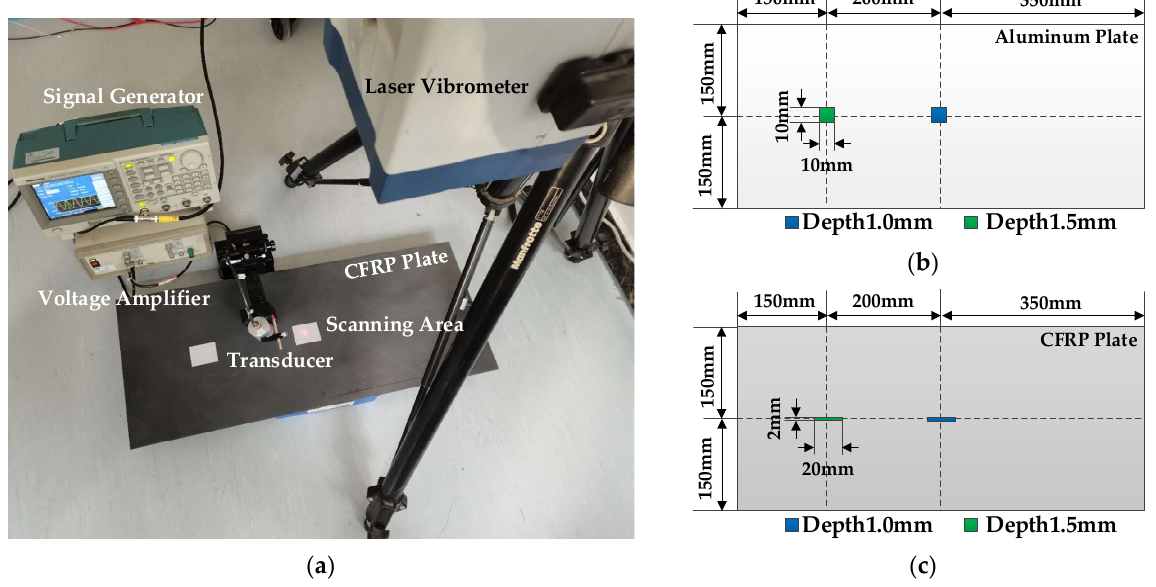
Figure 9. Experiment platform: ( a ) Experimental setup for the detection and estimation of damage on the CFRP plate; ( b ) The damage information of the tested aluminum plate; ( c ) The damage information of the tested CFRP plate.